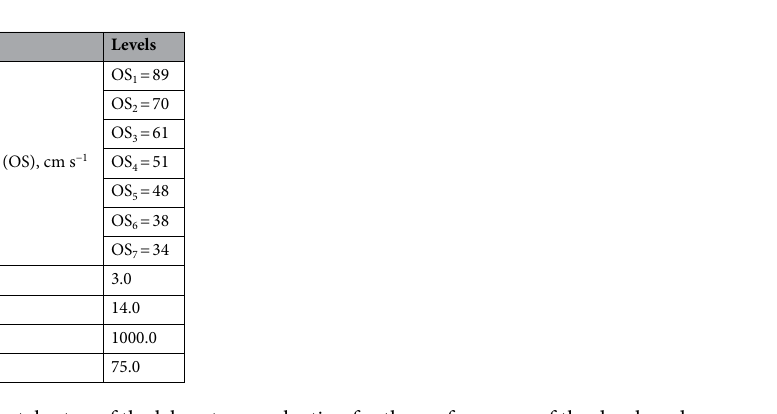
Table 2. The experimental setup of the laboratory evaluation for the performance of the developed mechanical carrot seeder.